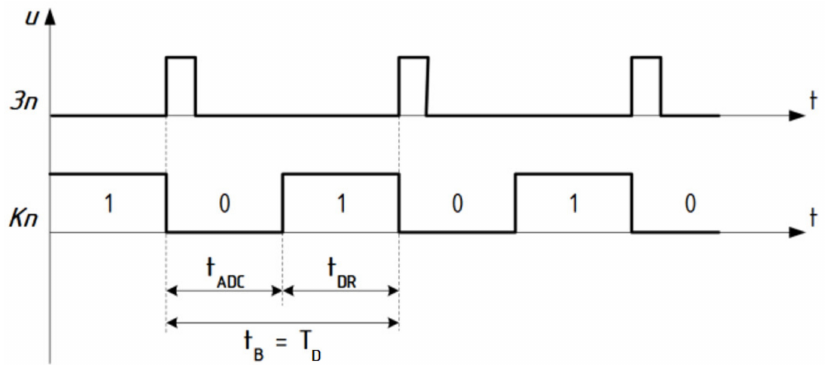
Figure 6. ADC timing